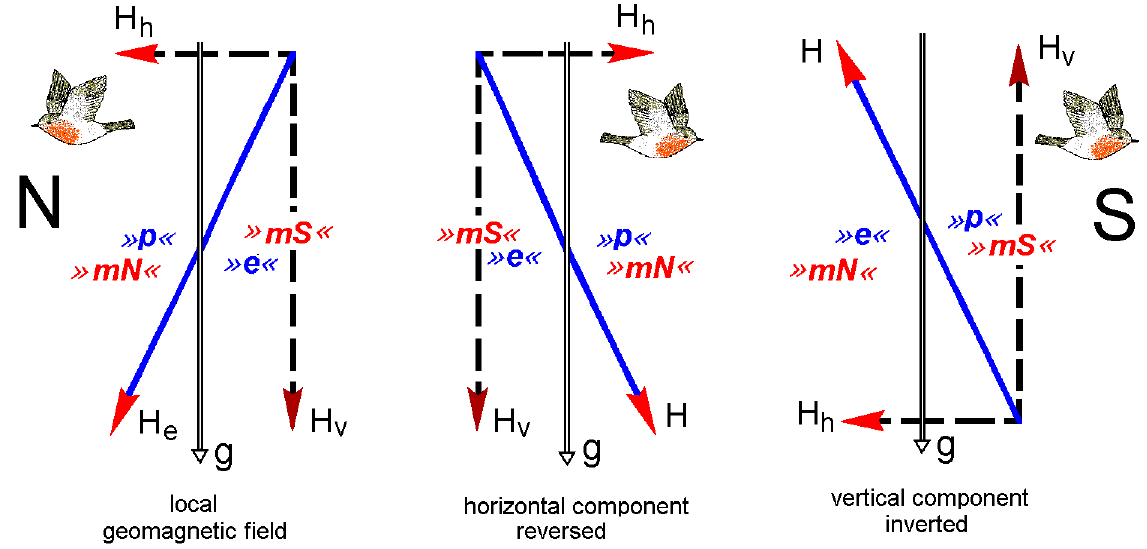
Figure 3. The avian inclination compass: cross-section through the magnetic field as seen from the West. N, S, geographic North and South; H, magnetic vector; He, vector of the local geomagnetic field; Hh, Hv. horizontal and vertical component of the magnetic field, with the red arrow tips indicating the polarity; the axial course of the field lines is indicated in blue. g, gravity vector indicating downward. Red »mN«, »mS«, magnetic North and South , the readings of a polarity compass; blue »p«, »e«, poleward and equatorward , the readings of the avian inclination compass. The robins’ flying direction indicates where the birds seek their spring migratory direction (after [19],